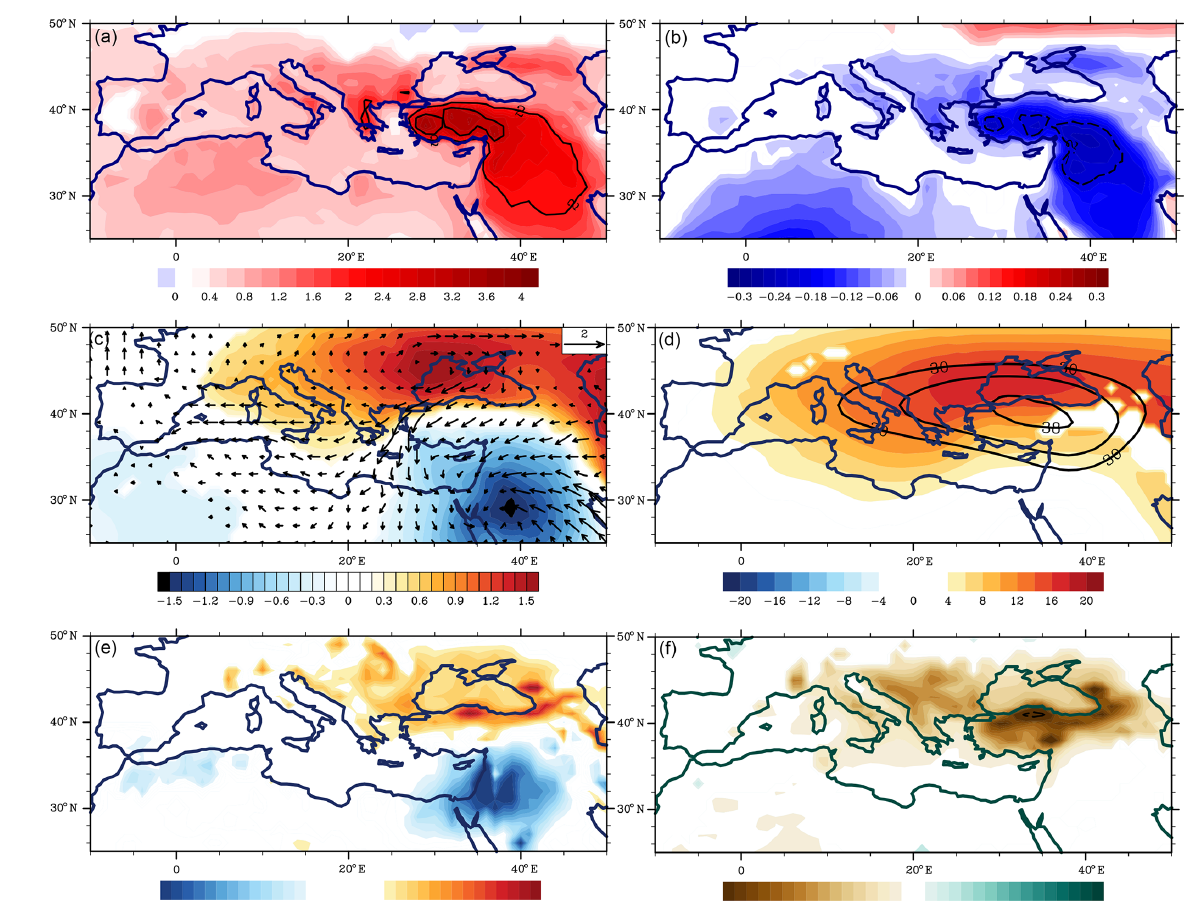
Figure 10. (a) Composite differences between the sample with the 300 warmest and 300 coolest seasons over the eastern Mediterranean (30–36 ◦ N, 36–42 ◦ E) for July in the CTRL run, derived from (a) surface temperature ( ◦ C), associated differences in (b) relative humidity, (c) SLP (hPa), and vector wind at 850hPa (ms − 1 ), (d) height at 850hPa (shaded) and 500hPa (contours), (e) ω at 500hPa, and (f) precipi- tation (mmd − 1